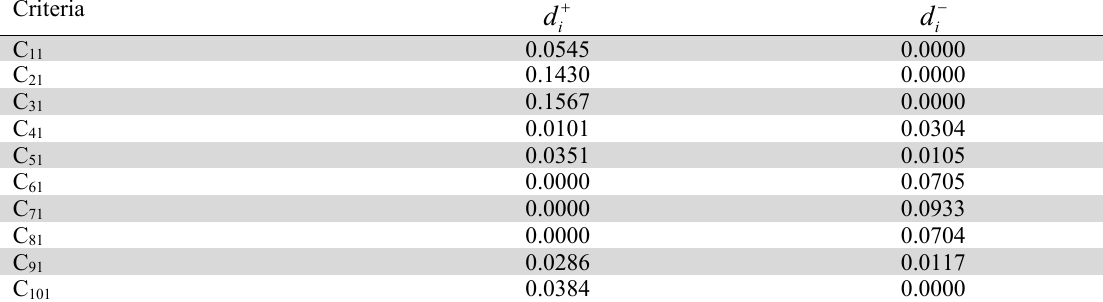
Ideal and not-ideal solution for the technical criteria Criteria